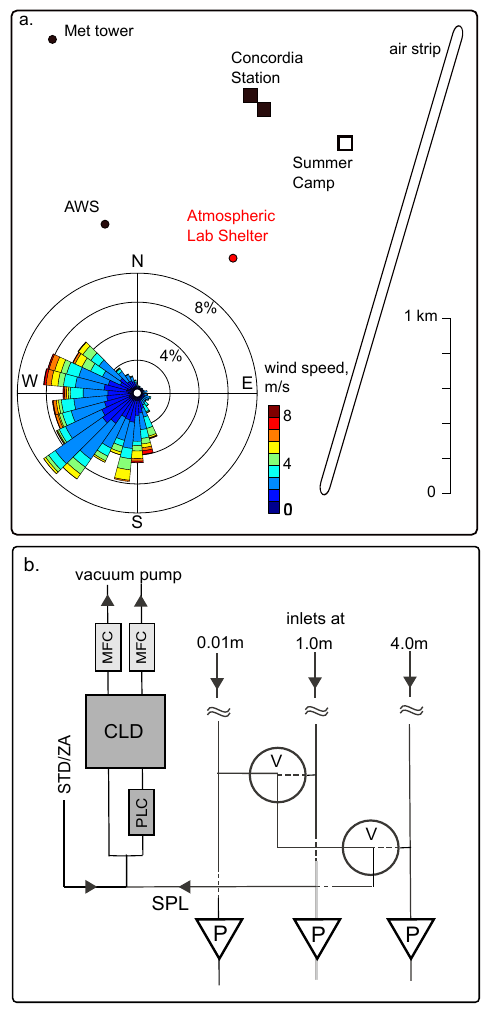
Fig. 1. (a) The wind rose for Dome C during December 2009 to January 2010 and location map of the atmospheric lab shelter, air strip, Concordia station, automatic weather station (AWS) and me- teorology tower with sonic anemometer. (b) Schematic of the NO x sampling set up: sample air (SPL) is drawn continuously by vac- uum pumps (P) from 3 inlet heights which are sampled by auto- matic switching of two 3-way valves (V). Sample flow into the chemiluminescence detector (CLD) through two channels, one with photolytic converter (PLC), is regulated by mass flow controllers (MFC). For calibration NO gas standard (STD) and for artefact tests zero air (ZA) are added upstream of the PLC. Triangles indicate flow direction (details in